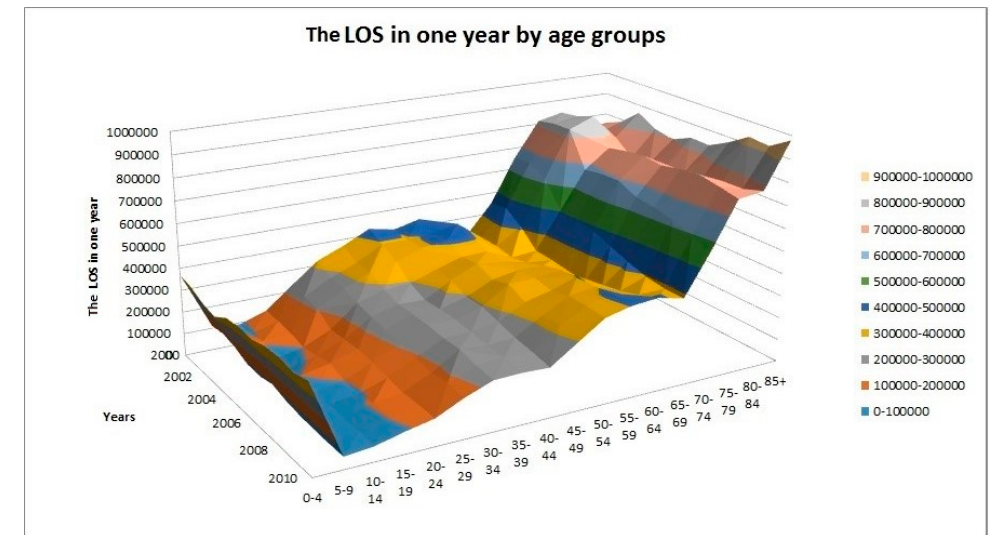
Figure 4. Total length of stay in hospital in each year by age group.